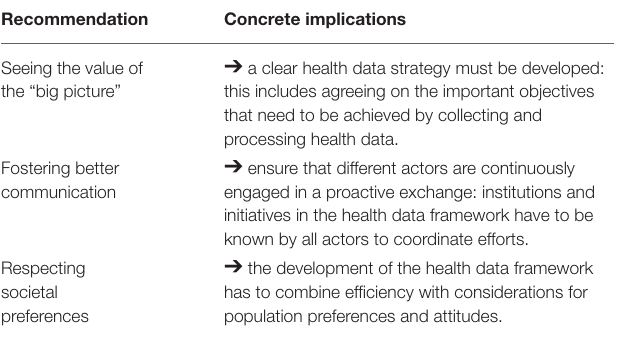
TABLE 1 | Recommendations concerning Mind-Set and attitudes. Recommendation Concrete